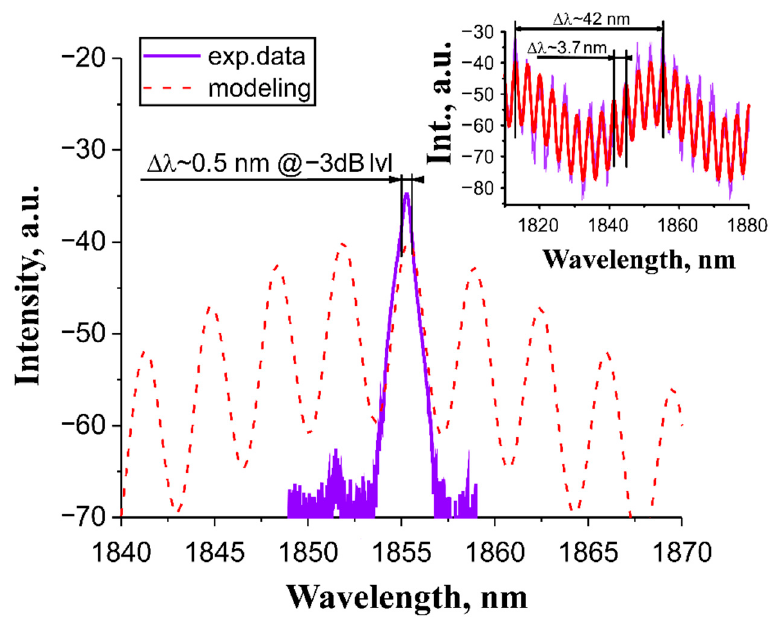
Figure 2. Optical spectrum (solid) and combined transmission function (TF) of two Lyot filters (dashed). Inset: experimentally obtained TF and its approximation.